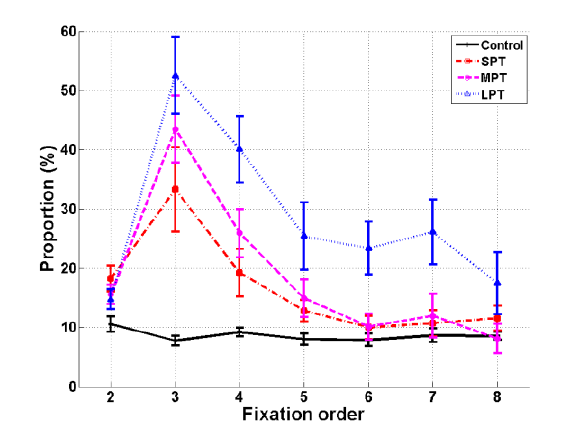
Figure 4: Mean proportion of fixations on the distractor location as a function of fixation order (fixations 2 to 8) for the control condition and the three distractor conditions (SPT, MPT and LPT). Error bars represent standard